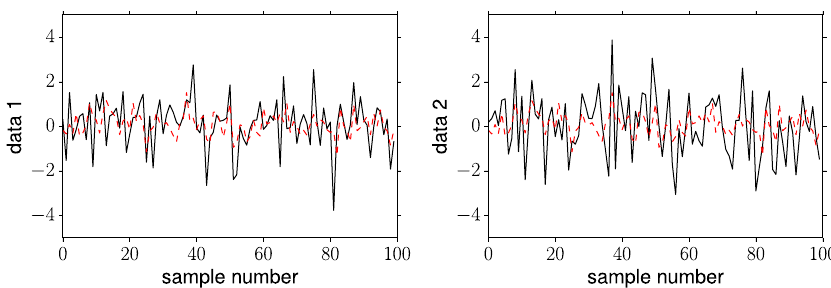
Fig. 16 Simulated data in the two detectors. The detector output is shown by the black curves ; the common stochastic signal is shown by the red dashed